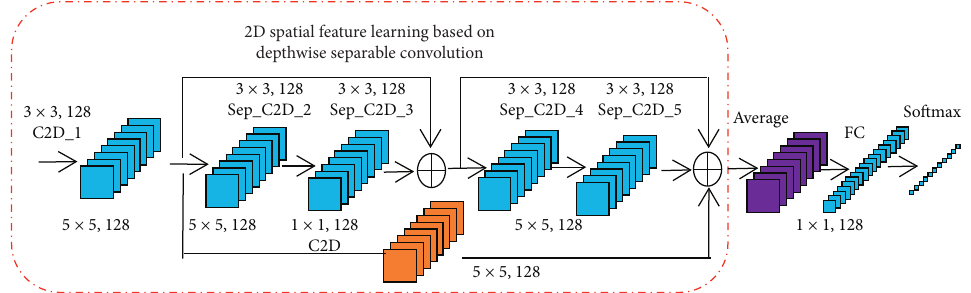
Figure 5: 2D spatial feature learning based on depth-separable